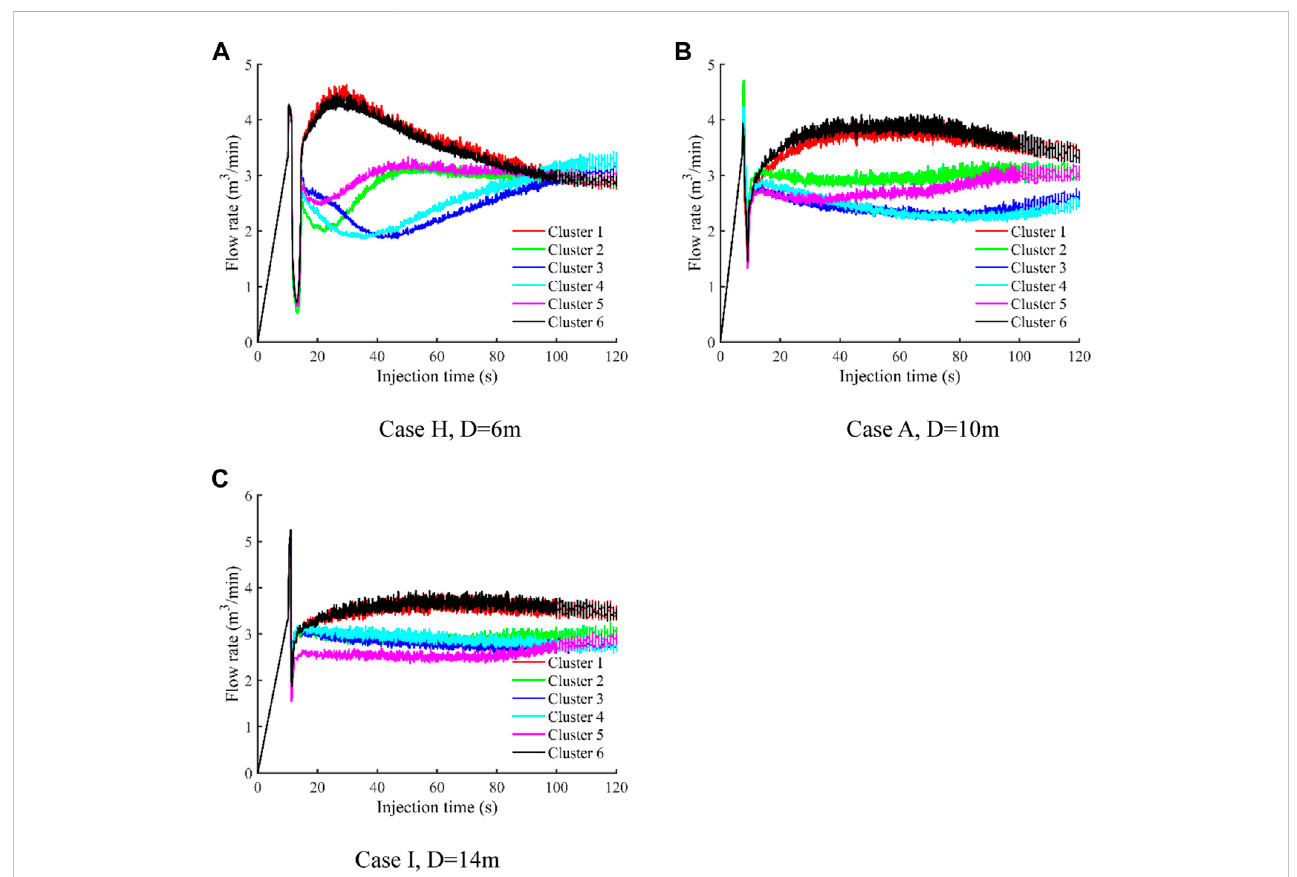
FIGURE 10 Flow rate into each cluster as a function of time for three cases with different cluster spacing. (A) Case H, D = 6 m. (B) Case A, D = 10 m. (C) Case I, D = 14 m.